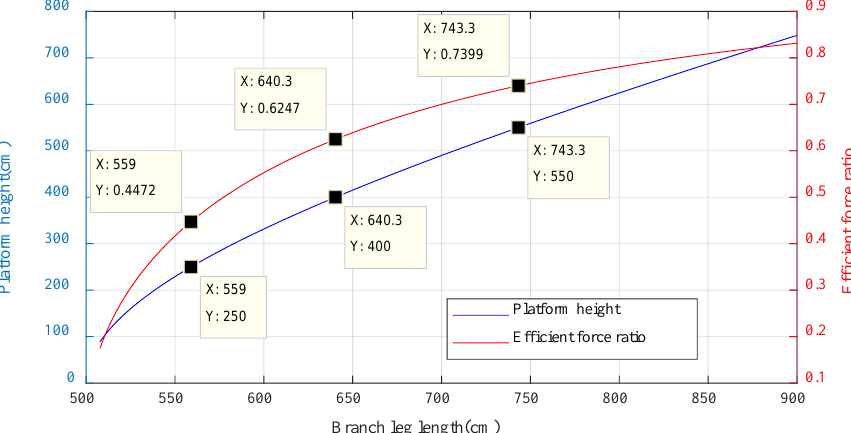
Figure 20. Curve of the relationship between branch leg length and the percentage of efficient support force, and the curve of the relationship between platform height and prismatic joint length.